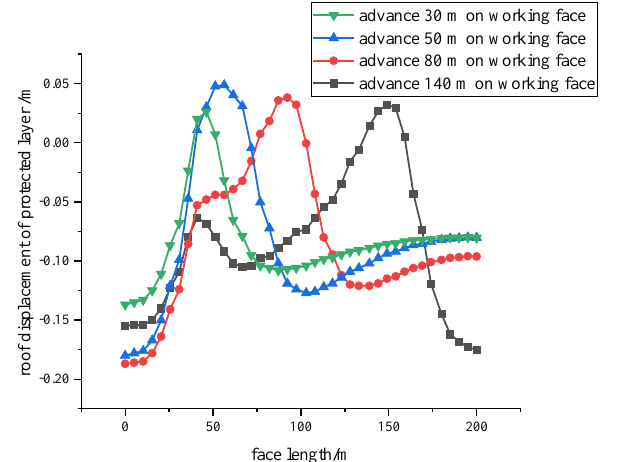
Figure 12. The working face pushes the roof displacement of the protected layer at different distances.